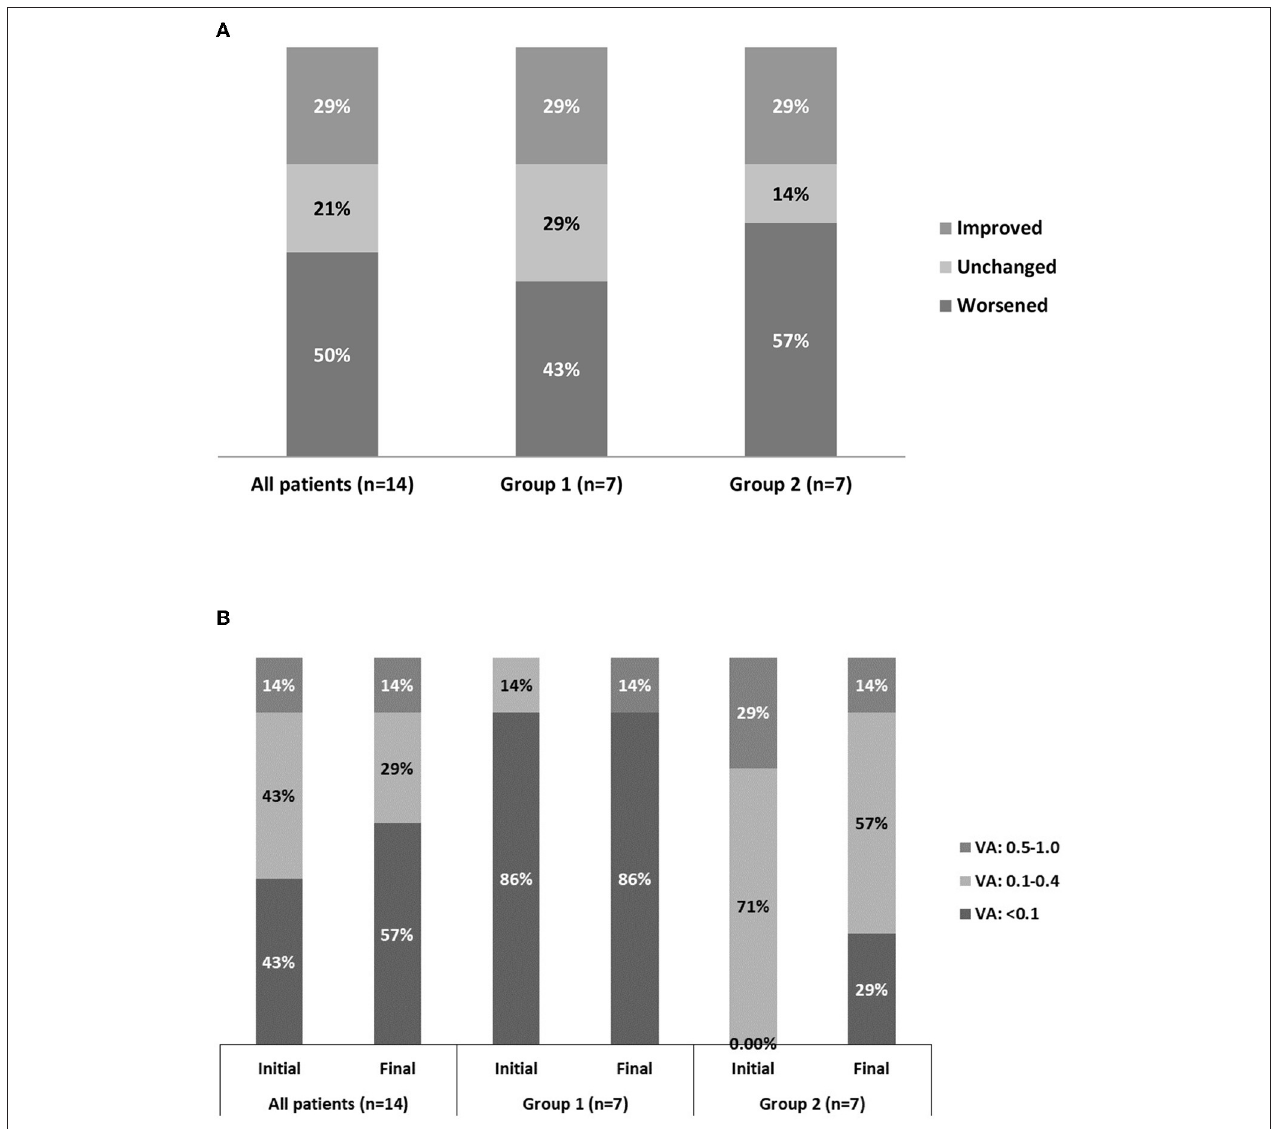
FIGURE 2 | Fourteen eyes with documented initial vs. final visual acuity. Group 1 comprises the eyes in which orbital apex syndrome was attributed to neoplastic causes. Group 2 comprises the eyes in which orbital apex syndrome was attributed to non-neoplastic causes. (A) Categorization of visual improvement. (B) Categorization of visual acuity as good (0.5–1.0), fair (0.1–0.4), and poor ( <